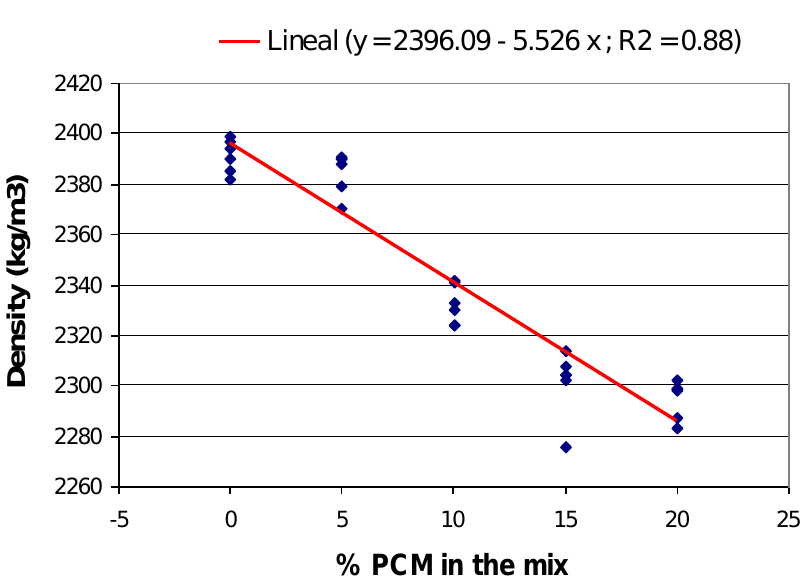
Figure 3. Density ratio to percentage of